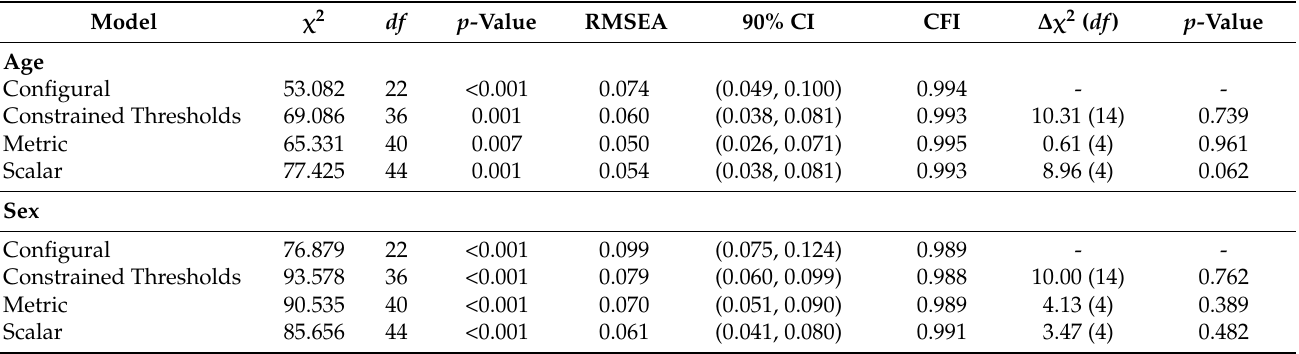
Table 4. Measurement invariance according to sex and age.